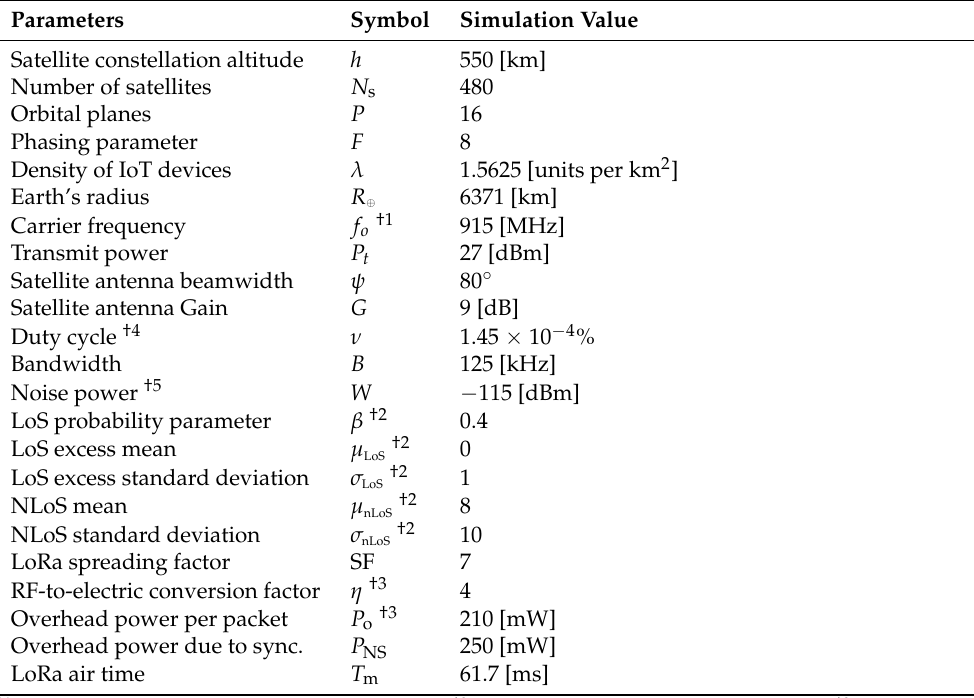
Figure 7. The Mercator projection of Walker-Star ( left ) for { h = 550 km, i = 87.5 ◦ , N = 480, P = 16, F = 8 } and Walker-Delta ( right ) constellations with same paramters except i = 54 ◦ , the blue patches represent the satellite footprints. Note that the satellite antenna beamwidth is set to 80 ◦ , in both constellations. Table 1. Simulation